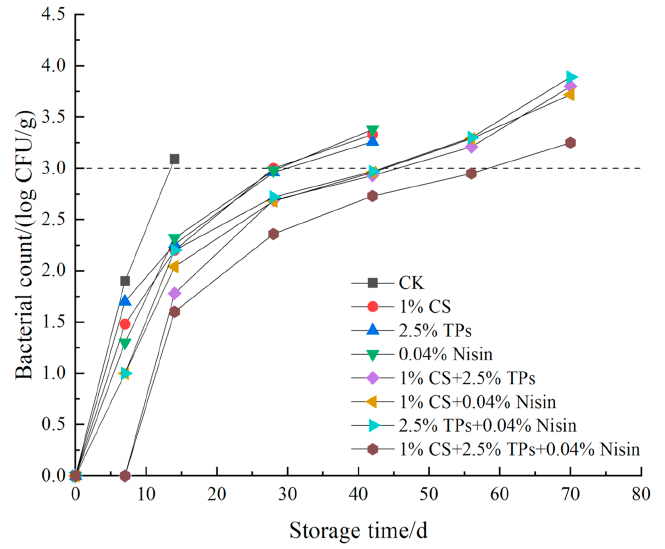
Figure 9. Effects of compound preservatives on S. aureus of plant-based meat. CFU, colony-forming units; CS, chitosan; TP, tea polyphenols; CK, control group.